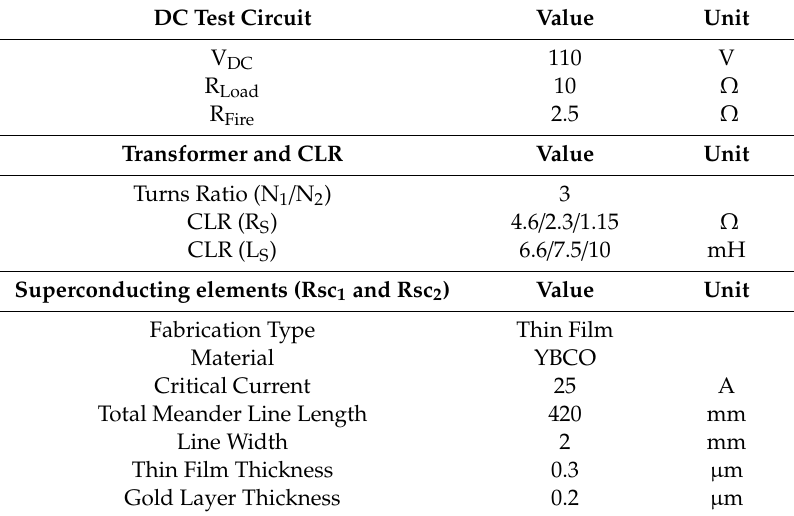
Figure 3. Schematic diagram of the DC experimental circuit with a DC SFCL using a transformer. Table 1. Main parameter values of the experimental circuit.